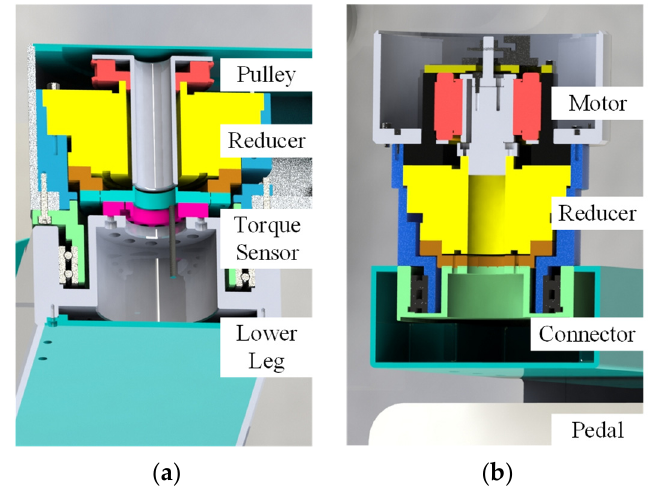
Figure 2. Section view of joint drivetrain: ( a ) knee joint and ( b ) ankle joint.